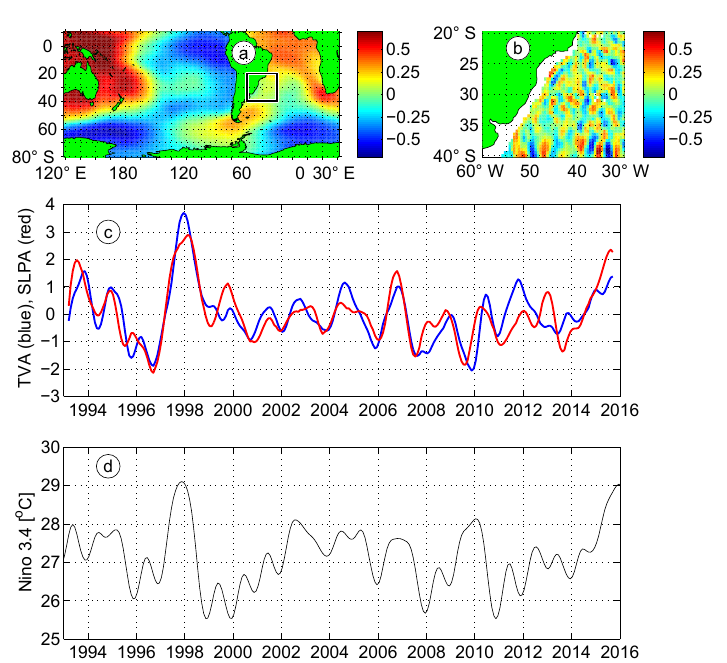
Figure 11. Second mode of coupled EOF of the anomaly of the meridional transport (TVA) from Argo&SSH and the anomaly of the sea level pressure (SLPA) from MERRA. The spatial patterns of the heterogeneous correlation maps are presented in (a) . The homogenous correlation (b) , the normalized time series of the expansion coefficients (c) , and the Niño 3.4 time series (d) are shown as well. The correlation between the expansion coefficients is 0.8, which is significant with respect to the 95% confidence level. See Fig. 10 for additional